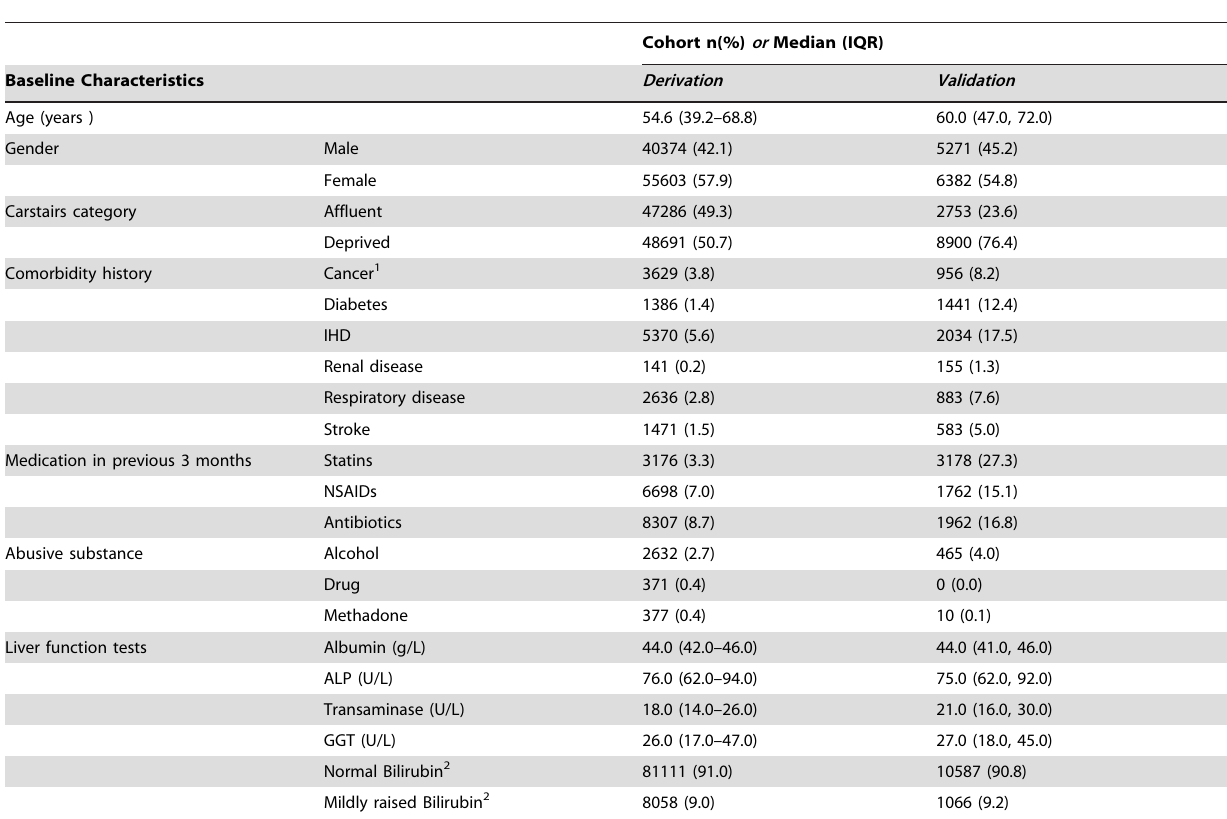
Table 1. Baseline and historical characteristics of the derivation cohort (n =95977) and the validation cohort (n=